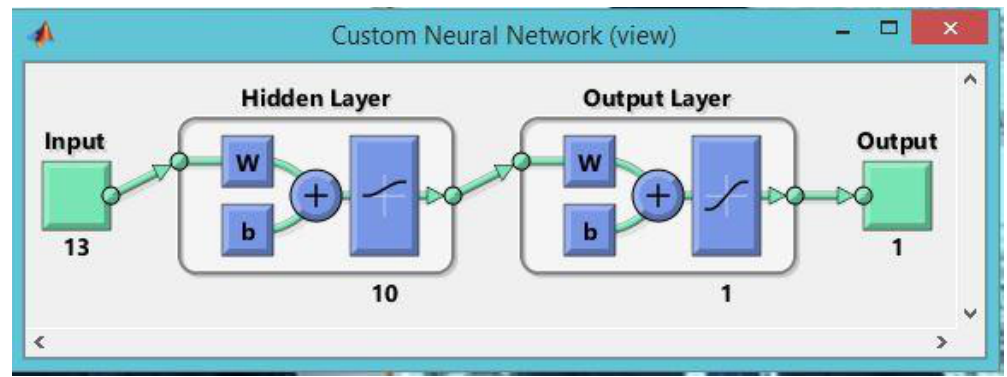
Figure 2. ANN (M 13.10.1 ) architecture plot of Perigiali